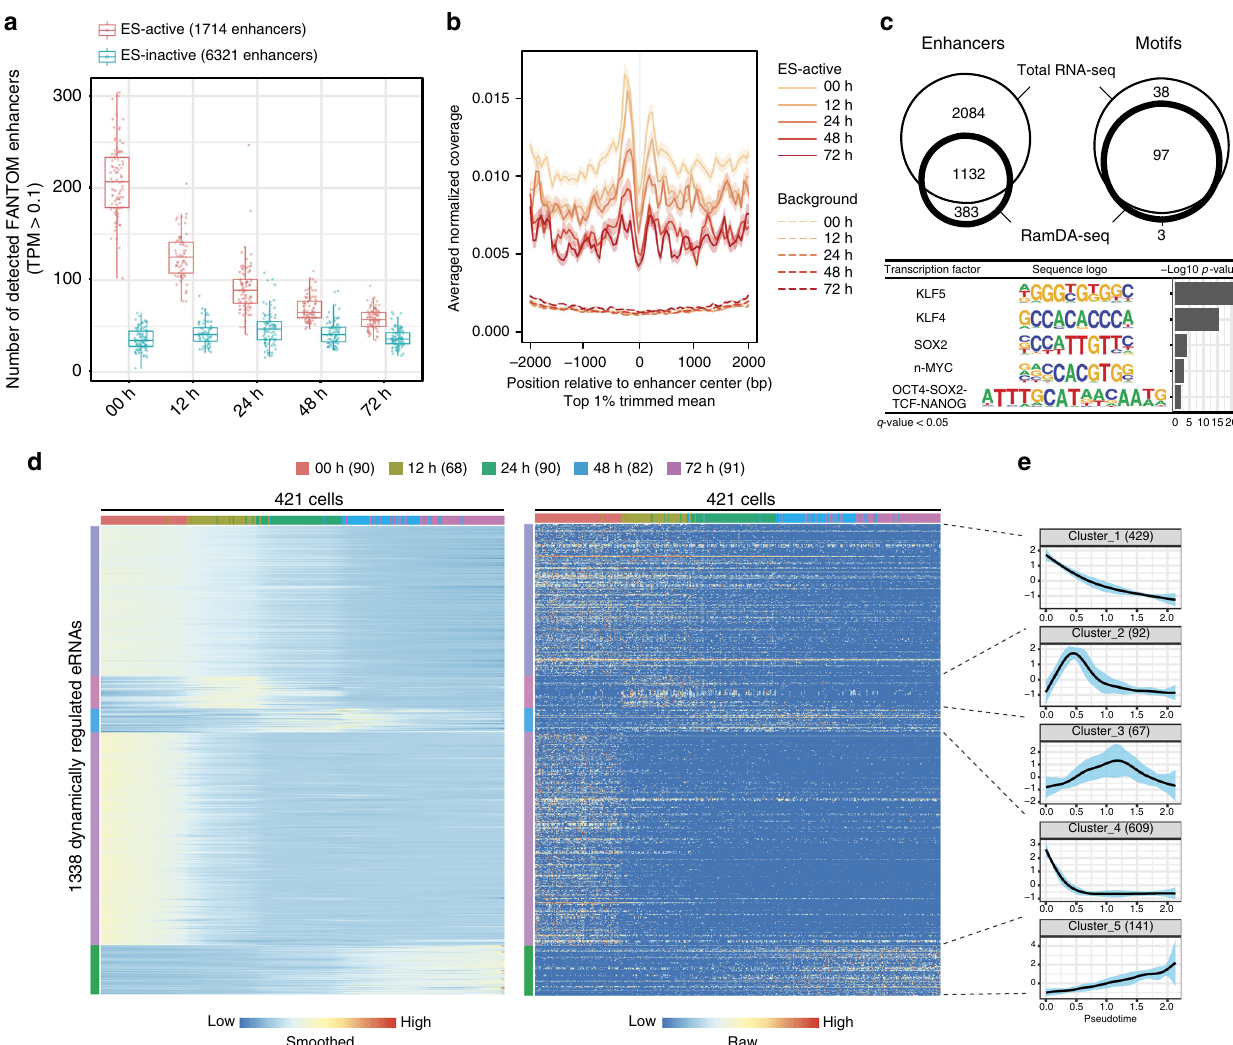
Fig. 5 Single-cell analysis of enhancer RNAs. a Number of detected FANTOM5 CAGE enhancers for the ES-active (red) and ES-inactive (blue) enhancers for each cell. The detection of each enhancer is called when the TPMexceed 0.1. The center line, and lower and upper bounds of each box represent the median, and fi rst and third quartiles, respectively. The lower (upper) whisker extends to smallest (largest) values no further than 1.5 × IQR from the fi rst (third) quartile. b Aggregation plot of the read coverage around the ES-active enhancers (solid lines; 1199 enhancers) and random genomic regions (dashed lines; 44 467 enhancers). Normalized read coverage was averaged across the cells and normalized to make the sum of each enhancer be 1 and were further averaged across enhancers after trimming the top 1% of enhancers for each 50-bp bin. Only the top 70% of highly expressed enhancers (quanti fi ed within regions 75 to 275 bp away from the center of enhancers) were included. The shaded areas represent SDs. c Motif analysis of enhancers detected by rdRNA-seq and RamDA-seq with ESCs. The number of detected enhancers (top left) and enriched known DNA motifs of transcription factors (top right) are shown in Venn diagrams. Sequence logos and p -values for enrichment (binomial test) are indicated at the bottom for overrepresented motifs ( q -value < 0.05) of transcription factors associated with self-renewal in ESCs. d Heat maps of the expression levels of eRNAs. Rows are ordered and colored by clusters. Columns are ordered by pseudotime and colored by sampling time points. Smoothed values are transformed to Z -scores for each row. Raw values are scaled from 0 to 1 for each row. The numbers in parentheses represent the number of cells. e Averaged expression pro fi le for each cluster of eRNAs. The x -axis represents pseudotime. Thin, colored areas represent SDs. The numbers in parentheses represent the number of